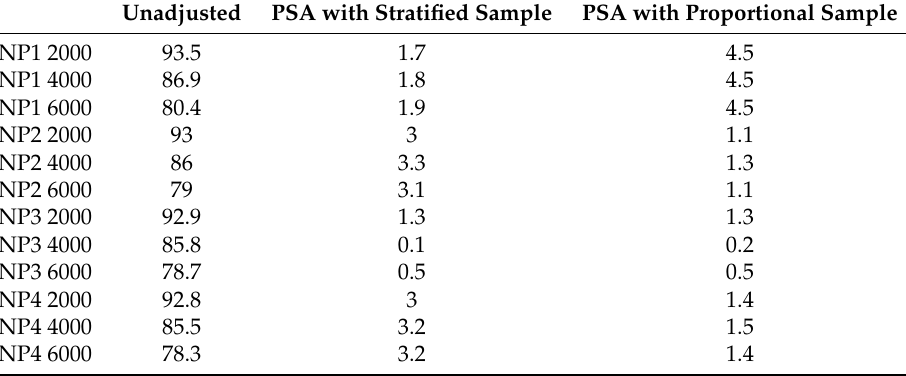
Table 10. Relative mean bias (%) for estimating HCI without and with applying